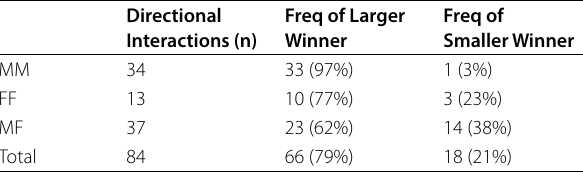
Table 5 Directional interactions on site 1